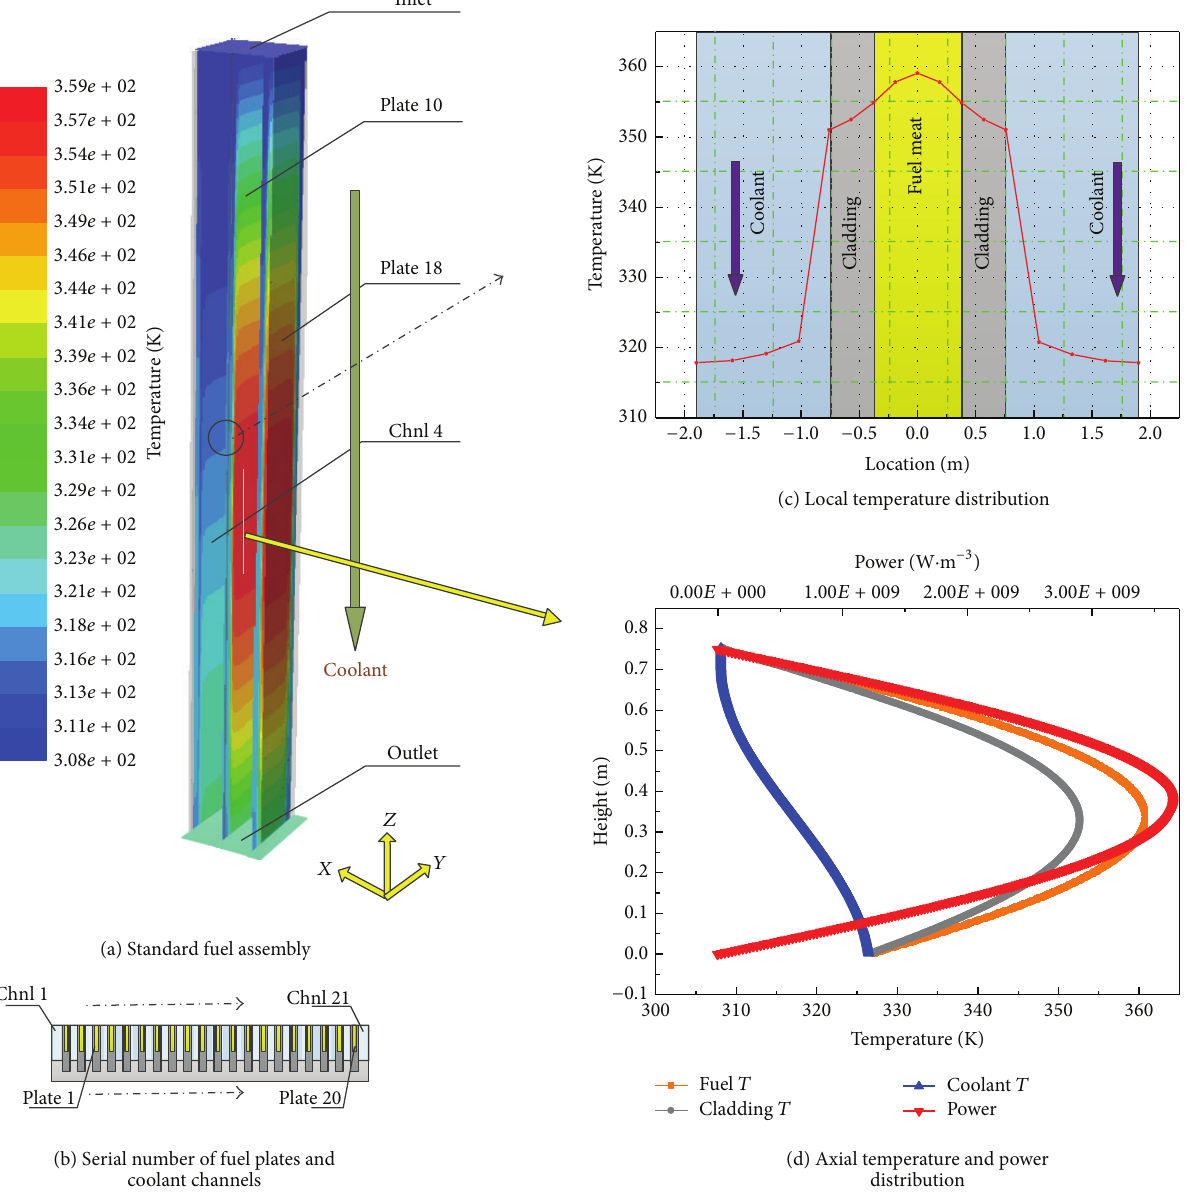
Figure 9: Axial temperature distribution of standard fuel assembly (inlet velocity: